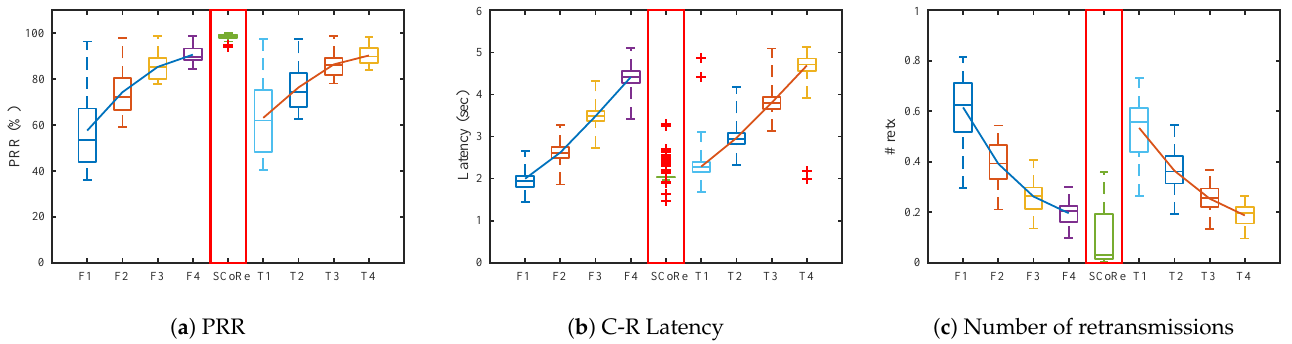
Figure 8. Simulation results when the root is placed at the top-left corner of the grid topology with M = 3, T C = 200 ms, K = 5 and varying T R .